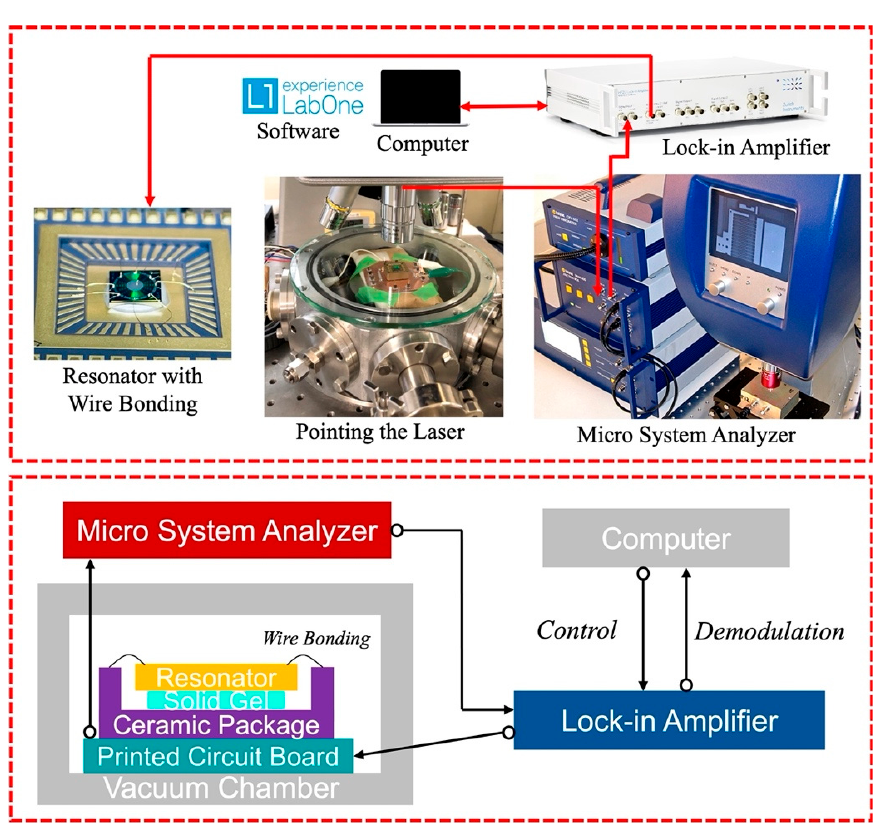
Figure 13. Schematics of applied evaluation system.